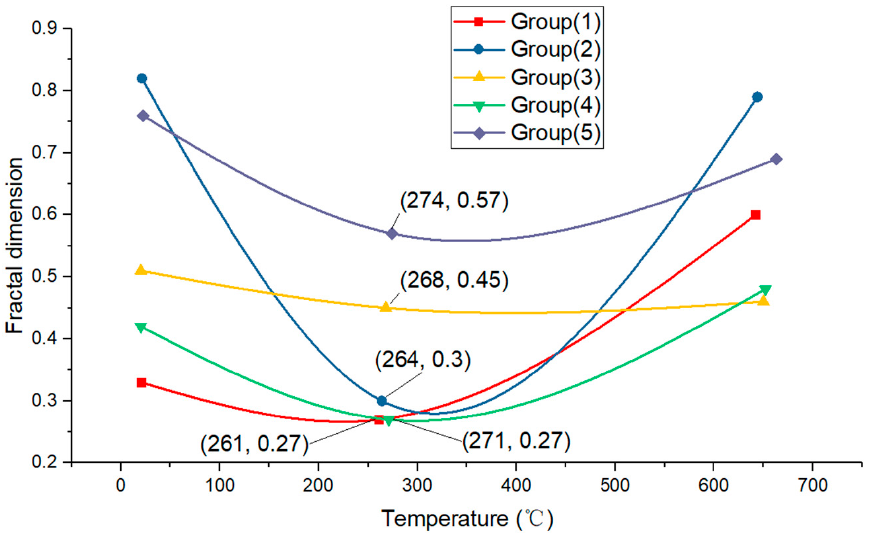
Figure 19. Fractal dimensions of different groups of samples at different temperatures.